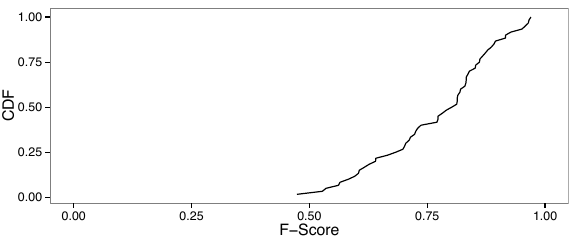
Table 2: Prediction Parameter for the Simulation Model